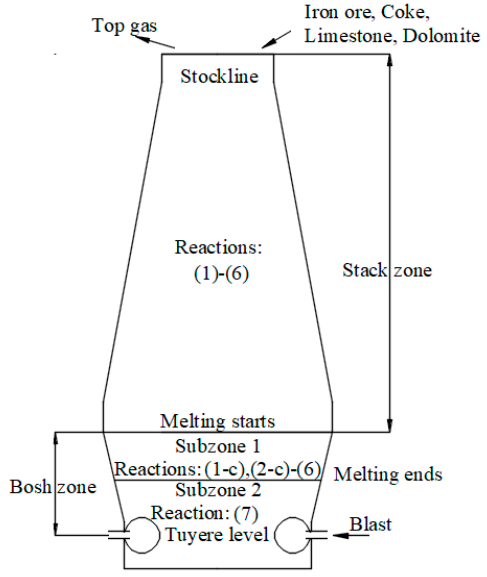
Figure 1. Schematic diagram of zones in blast furnace.